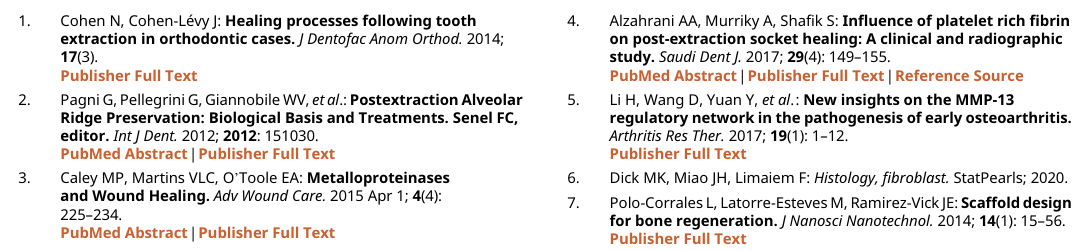
Figshare: Figure of Table for ‘ Pre-Clinical Study: Immunohistochemical evaluation of matrix metalloproteinase-13 on Rabbit (Oryctolagus cuniculus) socket healing after application of platelet-rich fibrin with and without hydroxyapatite ’ https://doi.org/10.6084/m9.figshare.16641181. 39